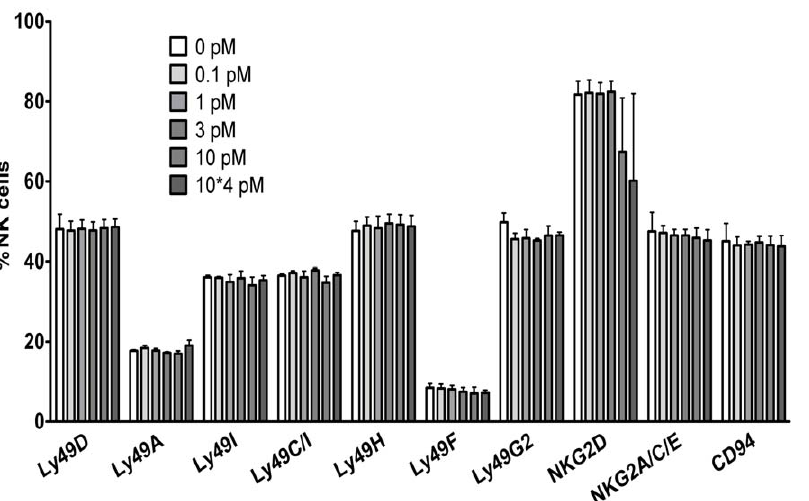
Figure 6. NGF does not modulate NK cell surface marker expression. Splenocytes were cultured during three days in the presence of IL-2 (1000 U/ml) and NGF at different concentrations. Then NK cells (CD3-NK1.1 + ) were analysed by flow cytometry for the expression of the surface markers indicated on the X-axis. Dead cells were excluded by staining with Live Dead cell marker. There were no significant differences between the two culture conditions for any of the markers tested (p . 0.05). The data represent the mean 6 SEM of three different experiments.